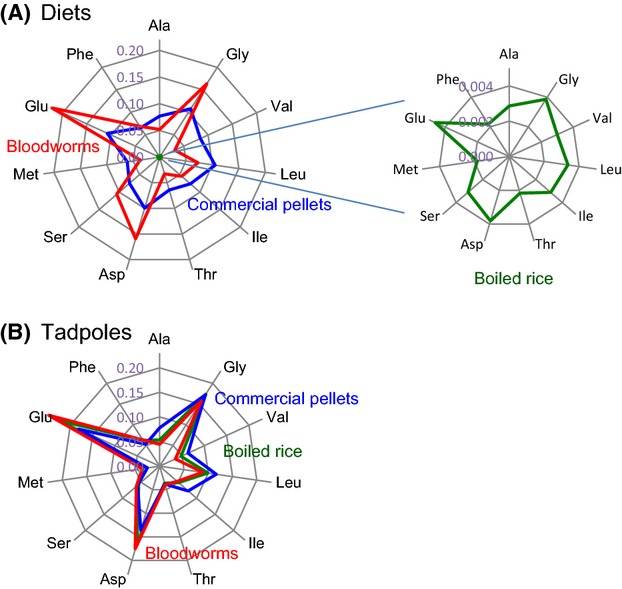
Molar ratios of 11 amino acids for (A) three diets (relative to sum of bloodworm - 1) and for (B) tadpoles on average the last 20 days before their front legs had emerged (relative to sum - 1).